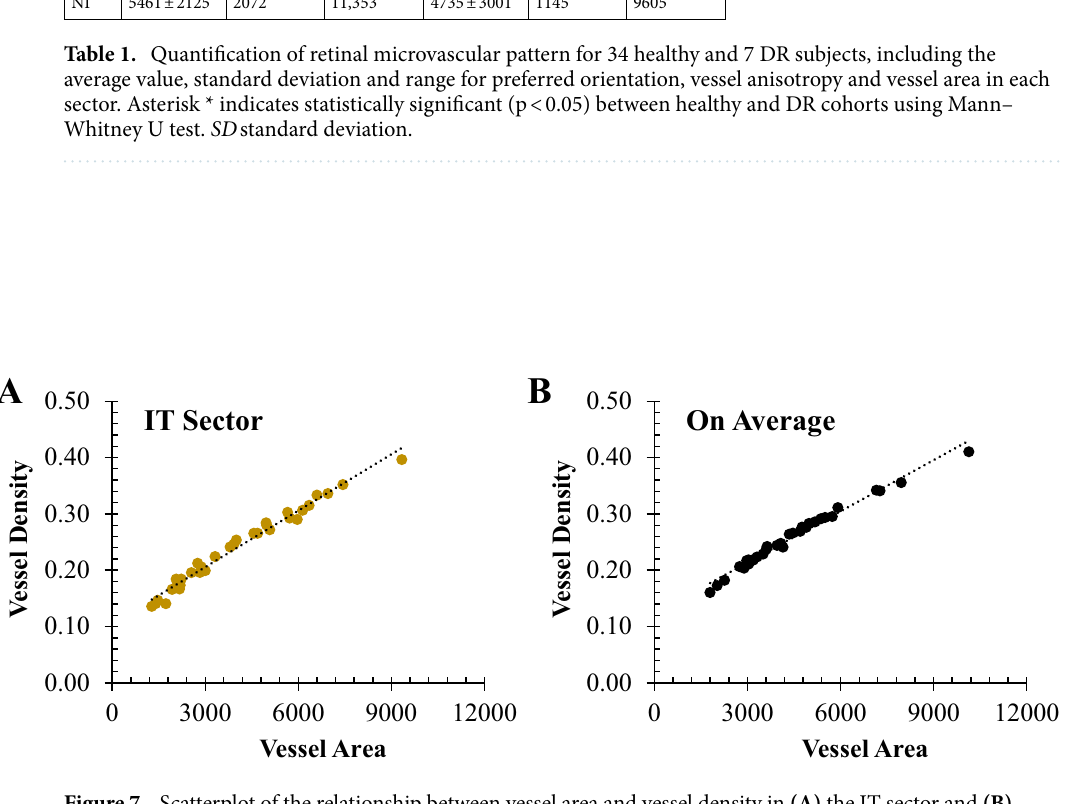
Figure 7. Scatterplot of the relationship between vessel area and vessel density in (A) the IT sector and (B) the average of 8 sectors in healthy subjects. The vessel area quantified from the retinal vascular orientation pattern was strongly correlated with the vessel density with Pearson R = 0.99 for both IT sector and on average (p < 0.0001, n =